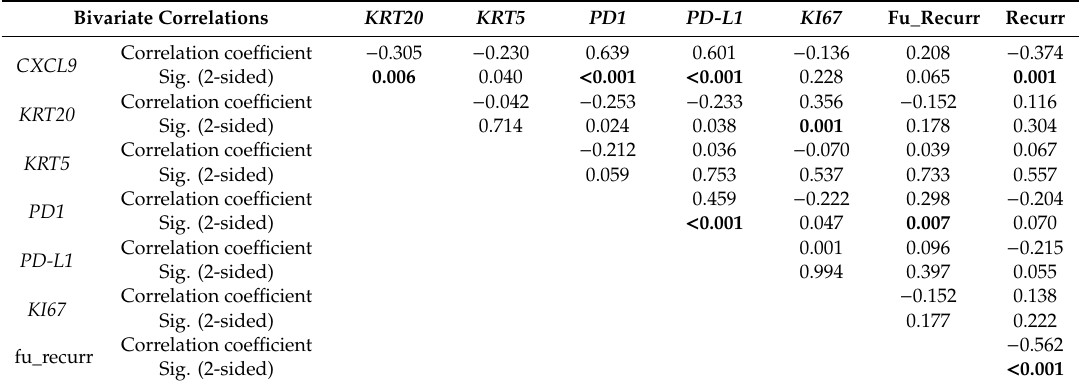
Table 1. Bivariate correlations for mRNA of CXCL9, KRT20, KRT5, PD1, PD-L1 and KI67 with clinicopathological